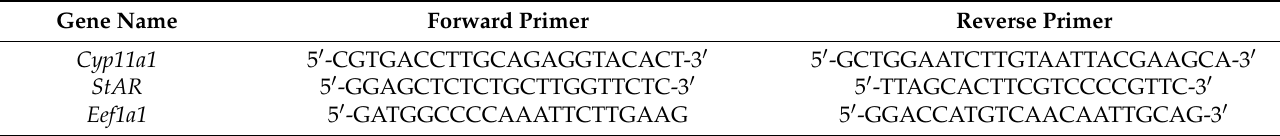
Table 1. Nucleotide sequence of the primers used for quantitative